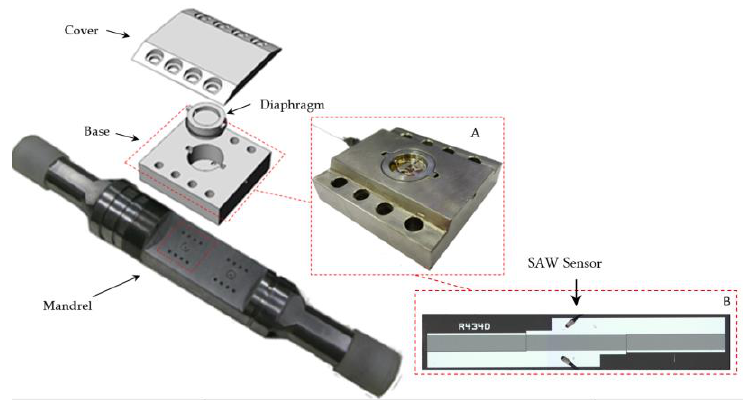
Figure 1. Pressure sensor assembly. In detail A : diaphragm mounted in the base. In detail B : top view of the SAW sensor.